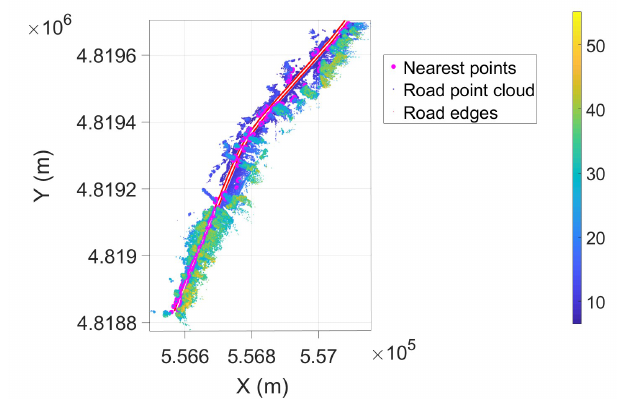
Figure 14. Vegetation detected with more than 15 m of